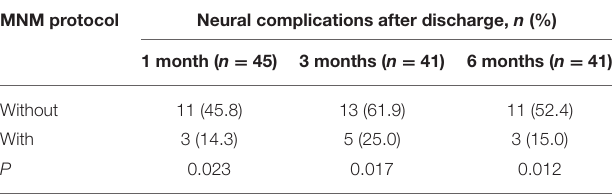
TABLE 6 | Effect of MNM protocol on long-term neurological outcomes. MNM